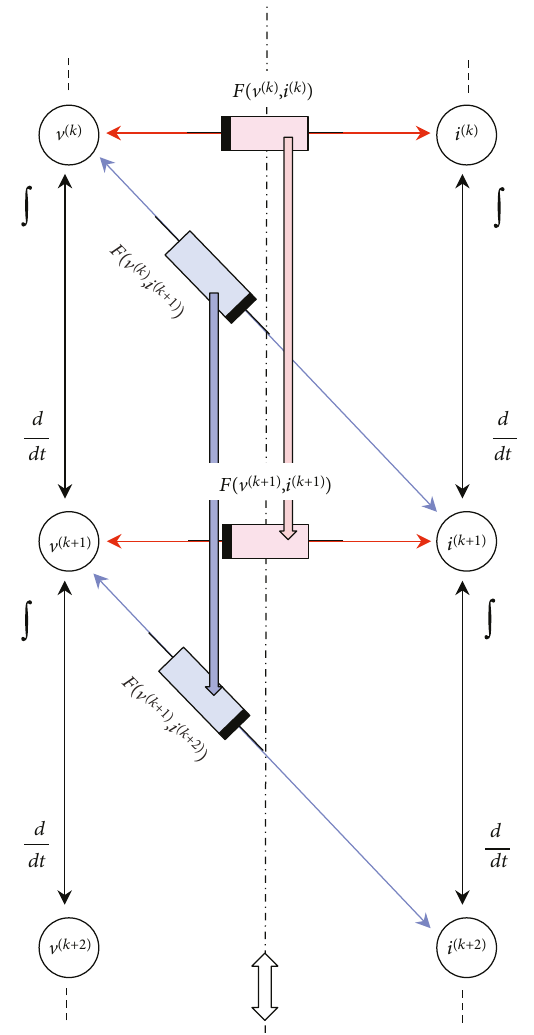
Figure 5: Generalized Chua ’ s duality as a “ shift-type ” transformation in the storeyed structure: each element has its dual counterpart, which appears in the structure just m fl oors below ( m > 0 ) or above ( m < 0 ) the original element. The elements are shifted along the dot-and-dash vertical line. This illustration is for m = 1